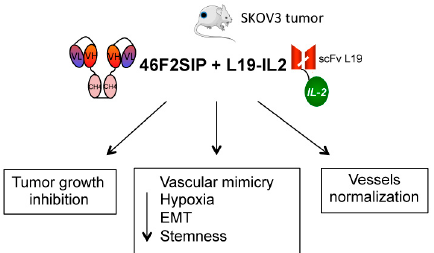
Figure 7. Schematic diagram of 46F2SIP/L19-IL2 combined therapy effects on SKOV3 human ovarian carcinoma model.